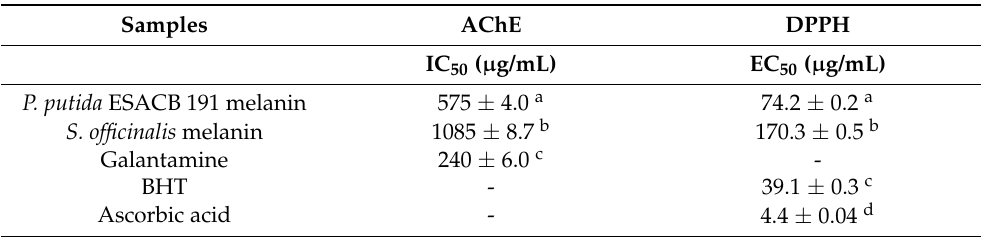
Table 2. IC 50 values for acetylcholinesterase (AChE) inhibition and EC 50 values for DPPH scavenging activity of the Pseudomonas putida ESACB 191 and Sepia officinalis melanin, galantamine, butylated hydroxytoluene (BHT), and ascorbic acid. The standard deviation values were calculated based on three replicates for each condition; different superscript letters (a, b, c and d) correspond to values in the same assay condition that can be considered statistically different (95% confidence level).